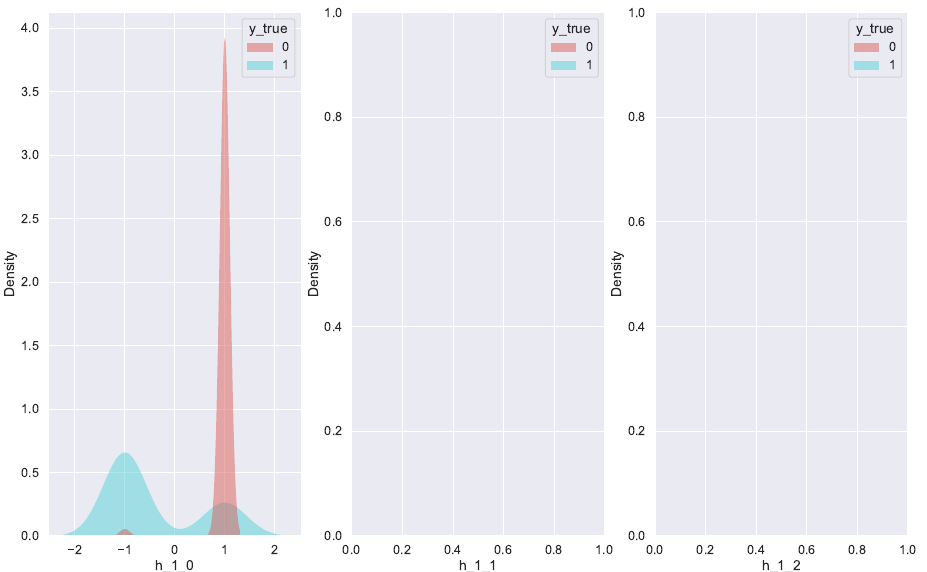
Figure 10. Histogram of binary activations generated employing KDE for neurons in hidden layer one in DL predictor for BCWD dataset. Each plot shows the activation density function per neuron discriminated by class (class 0 is shown in red, and class 1 is shown in blue). Neurons h_1_1 and h_1_2 show an empty plot because they have zero variance and present the same activation value for all the samples, thus are not